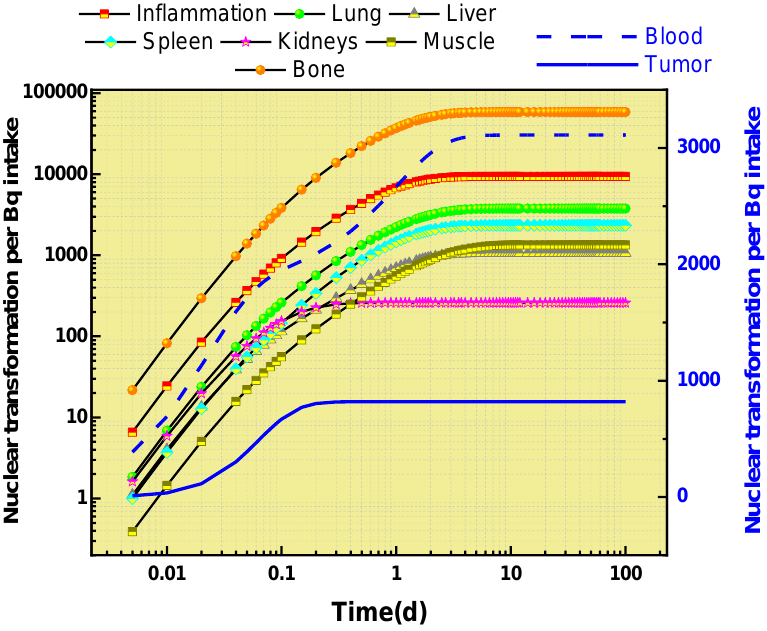
Figure 4. Nuclear transformation per Bq intake of 89 Zr-oxalate with time (d) for some organs.